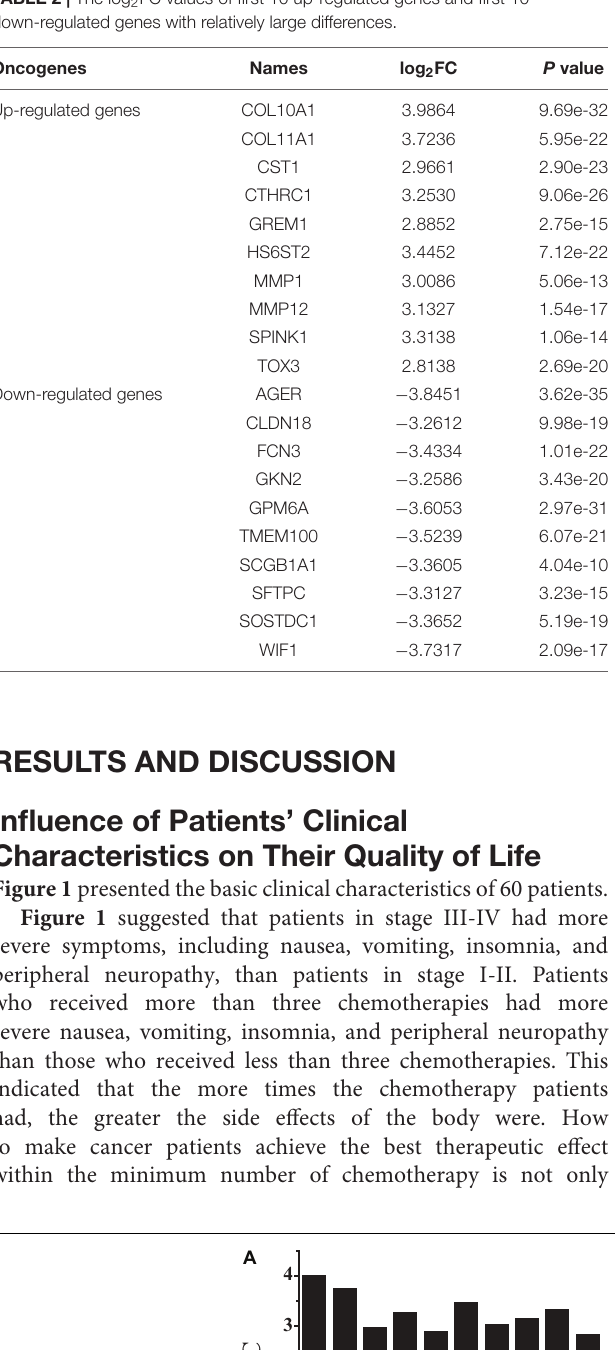
Frontiers in Genetics |